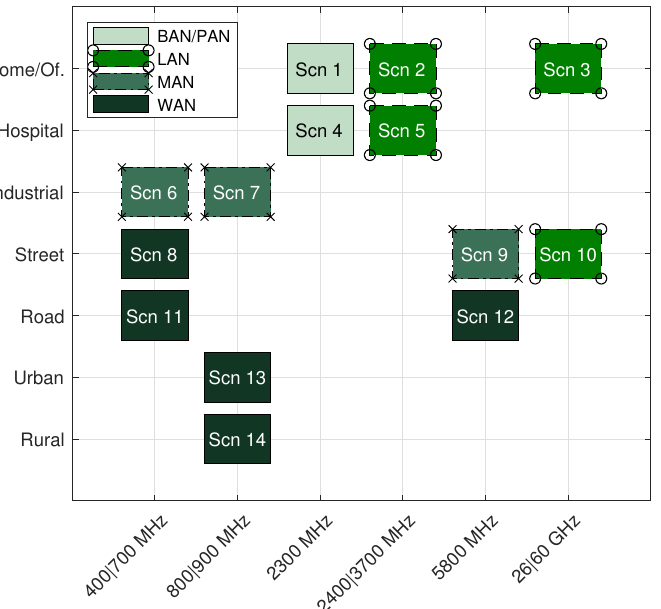
Figure 3. Coverage requirement per scenario (Body, Personal, Local, Metropolitan and Wide Area Networks). Short range coverage allows more efficient and intensive sharing spectrum schemes. Scenarios 2, 3 and 10 will not have competition from cellular